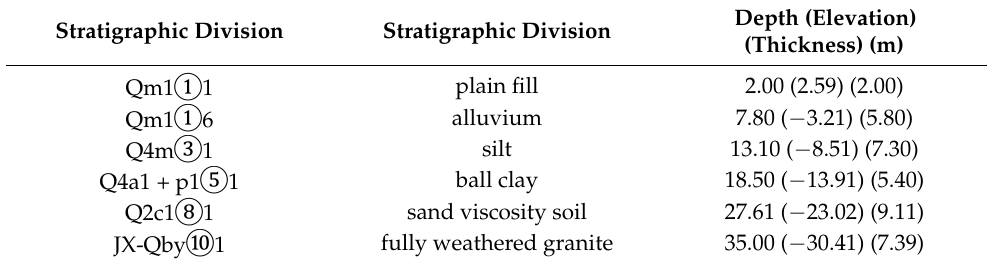
Table 1. Geological condition of the reclaim strata.